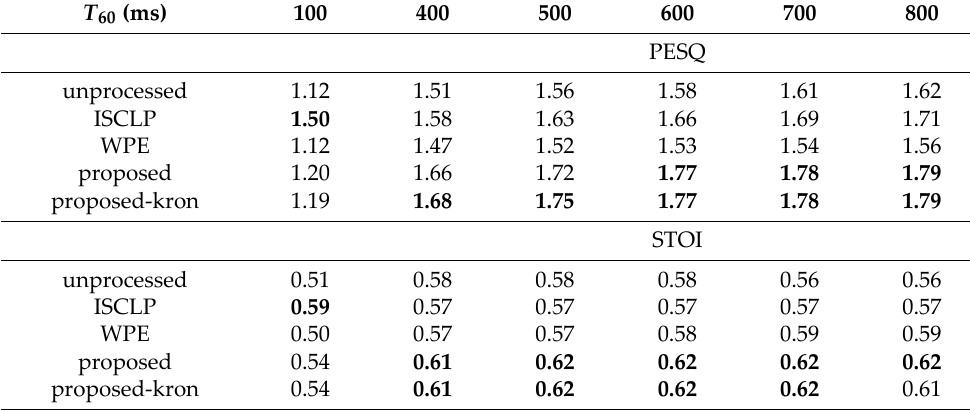
Table 1. Comparison of the test results at − 5 dB for babble noise. (The bold in the table indicates the best